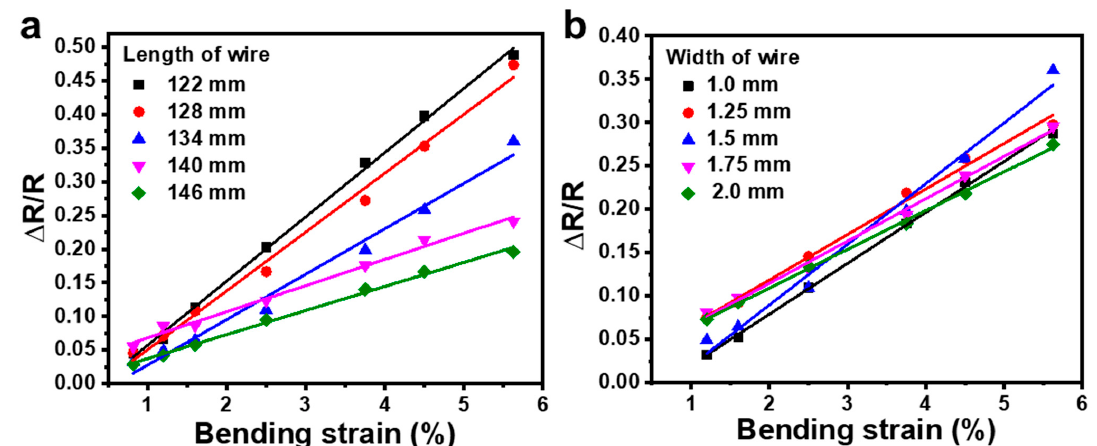
Figure 8. Change in relative resistance with bending strain when the devices were constructed with ( a ) different lengths and ( b ) different widths of wires in the serpentine structure.